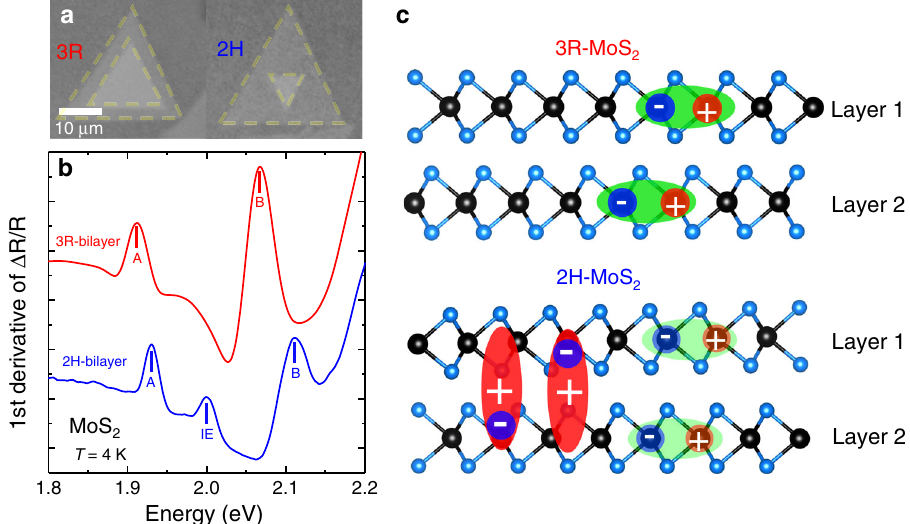
Fig. 1 Spectroscopy of as-grown CVD bilayers encapsulated in hBN. a Optical microscope images of as-grown 3R (left) and 2H CVD MoS 2 bilayers (right) on SiO 2 /Si before pick-up. b First derivative of white light re fl ection spectrum for as-grown 2H-bilayer (blue) and as-grown 3R-bilayer (red), recorded at T = 4 K, both bilayers are encapsulated in high-quality hBN for optical spectroscopy 29 . c Schematic of 3R stacked bilayer with intralayer excitons (top) compared to 2H stacked bilayer where in addition interlayer excitons are observed as in panel ( b